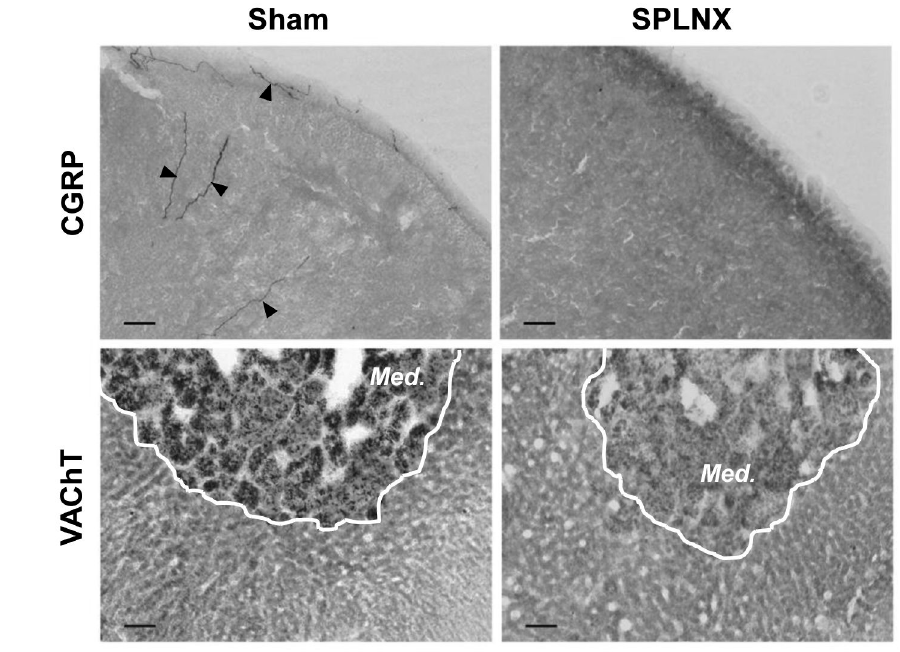
Figure 5. Splanchnicectomy effectively removed primary afferent and pre-ganglionic sympathetic innervation of the adrenal. Immunohistochemical labeling for calcitonin gene-related peptide (CGRP; top ) and the vesicular acetylcholine transporter (VAChT; bottom ) in representative adrenal sections from Sham ( left ) and SPLNX ( right ) treated rats. CGRP-positive fibers (arrows) are found in capsule and cortex of adrenals from Sham rats, whereas VAChT-positive fibers are found in the medulla ( outlined by white line; Med ). Note labeling for each marker is absent in adrenals from SPLNX rats, confirming the removal of splanchnic innervation. Bars = 100